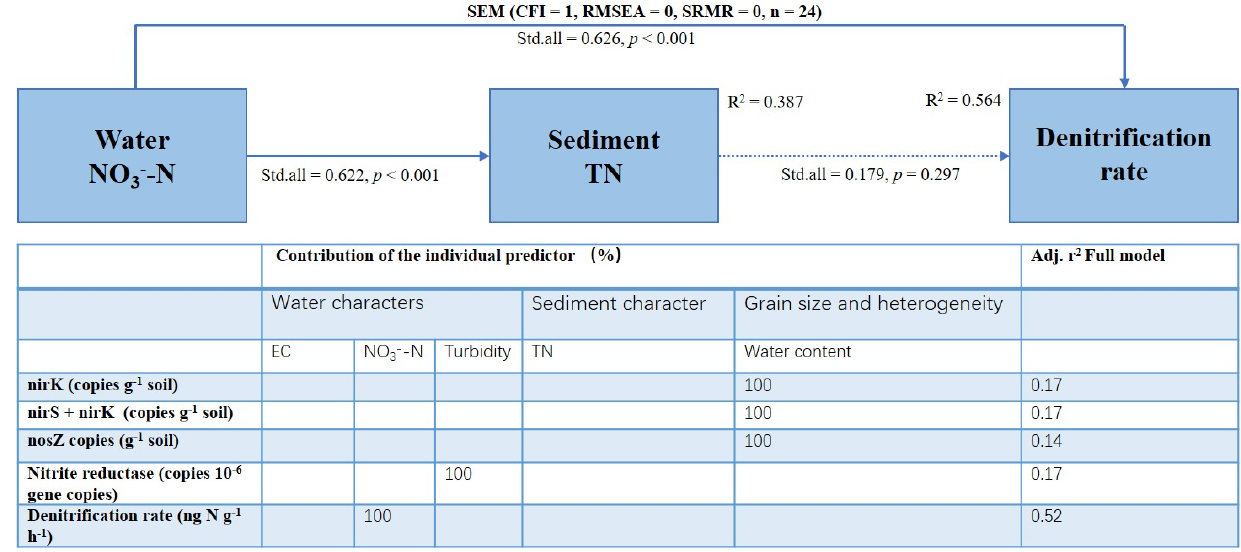
Figure 5. Model summary for the SEM and the stepwise multiple regression of denitrification factors on five environmental variables. Continuous and dashed arrows indicate significant and insignificant relationships.